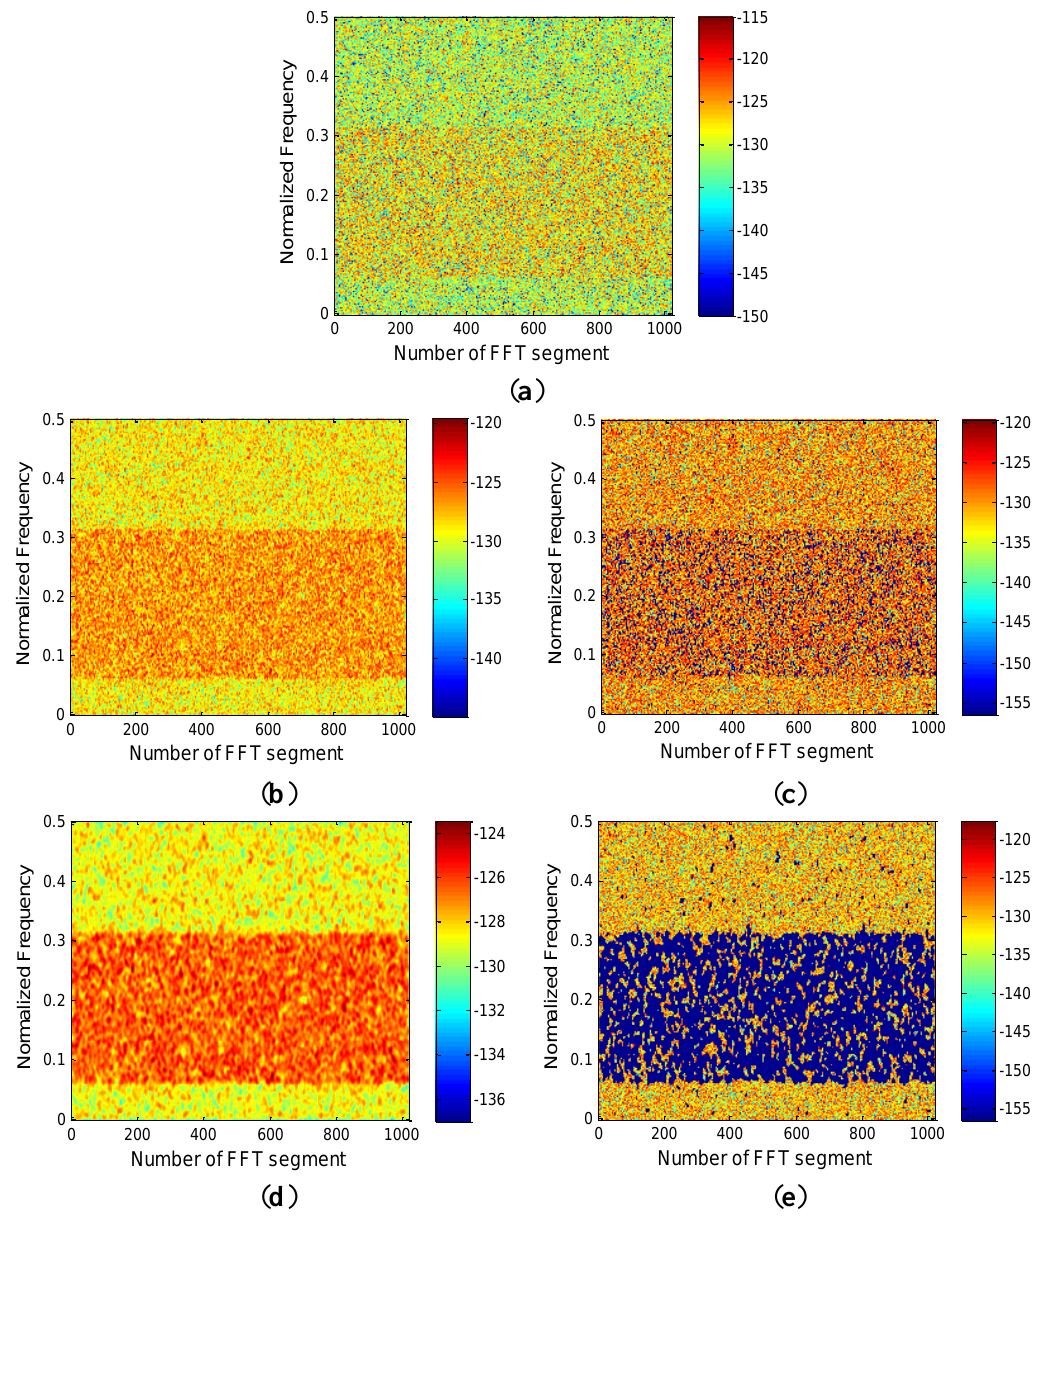
Figure 15. Smoothing Algorithm applied to a simulated OFDM RFI contaminated radiometric signal. ( a ) RFI contaminated signal’s spectrogram, σ 2 Convolution of the spectrogram with a: ( b ) 5 × 5 Hann window; ( d ) 15 × 15 Hann window; ( f ) 25 × 25 Hann window; ( h ) 35 × 35 Hann window; RFI-mitigated spectrogram using the most suitable threshold for a smoothing of a (Table 3); ( c ) 5 × 5 Hann window; ( e ) 15 × 15 Hann window; ( g ) 25 × 25 Hann window; ( i ) 35 × 35 Hann window.